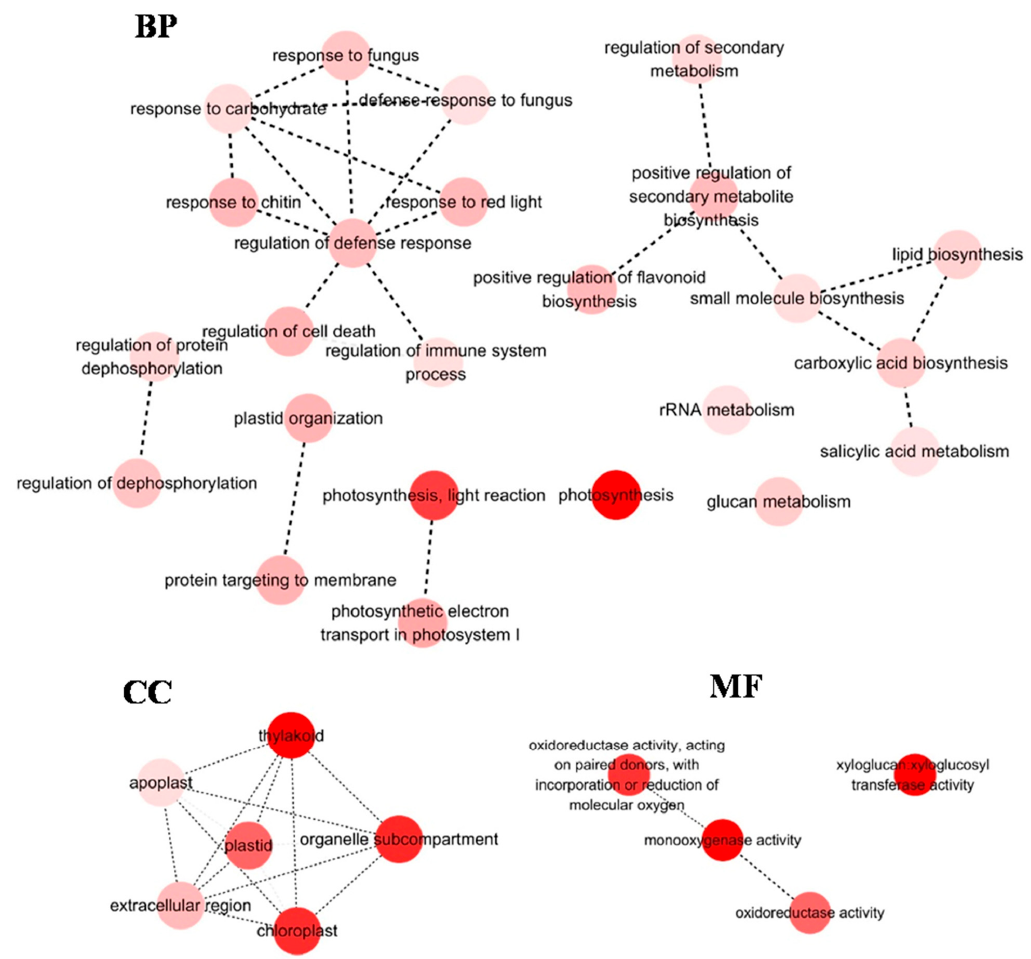
Figure 4. Gene ontology (GO) terms enrichment analysis of DEGs (24 h) in shoot. Few GO terms were over-represented in S6 libraries. Therefore, only GO terms enrichment in S24 libraries were displayed. The genes were assigned to three main categories: biological process (BP), molecular function (MF) and cellular component (CC). Node filled color represented p value. White nodes were not significantly over-represented terms.